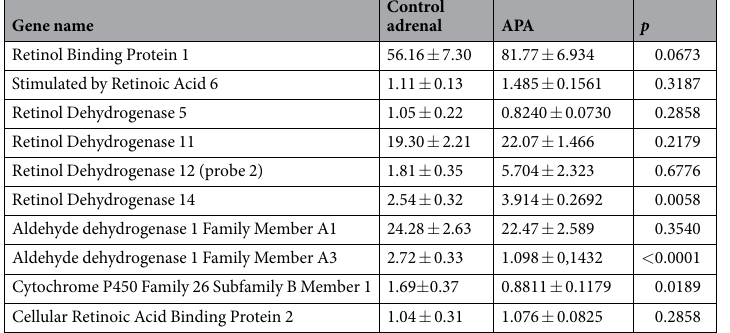
Table 2. Expression of enzymes responsible for retinoic acid biosynthesis in control adrenals (n = 11) and in APA (n = 48). Data are presented as mean ± SEM and are compared with the Mann-Whitney test or t-test (p significant if < 0.05). Data are expressed as log2.